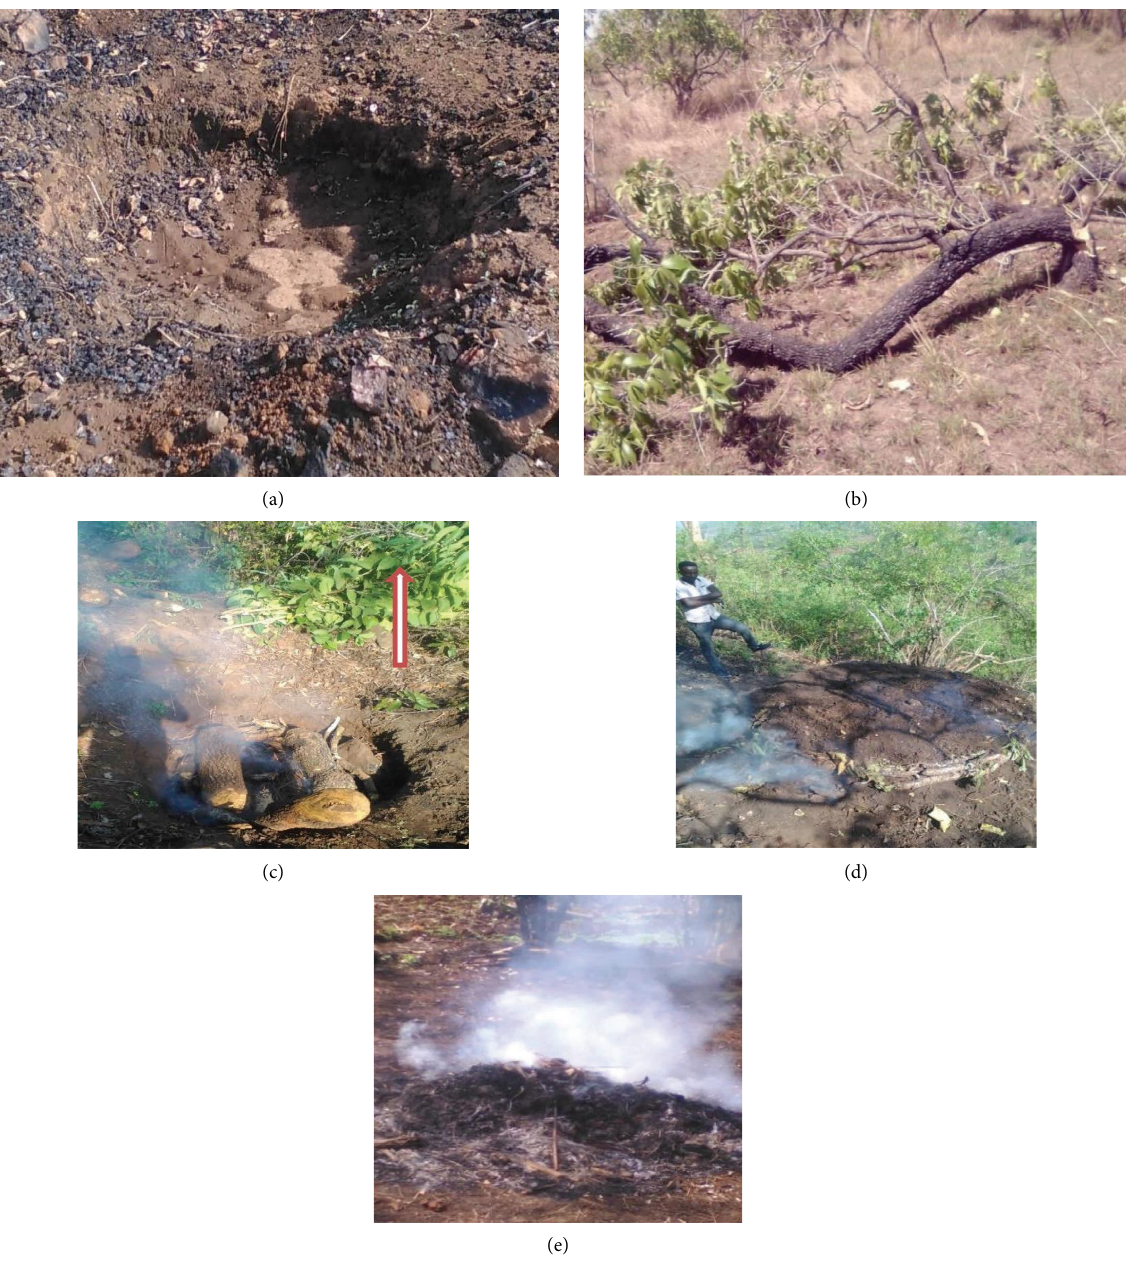
Figure 3: Various stages in the preparation of traditional earth mound kiln in Ofa Woreda: (a) prepared bench mark hole of the kiln; (b) felled/stacked woody tree into a kiln; (c) wood covered with herbaceous vegetation; (d) complete kiln covered with soil and burning slowly; (e) fred kiln. source: observations (feld photos by author